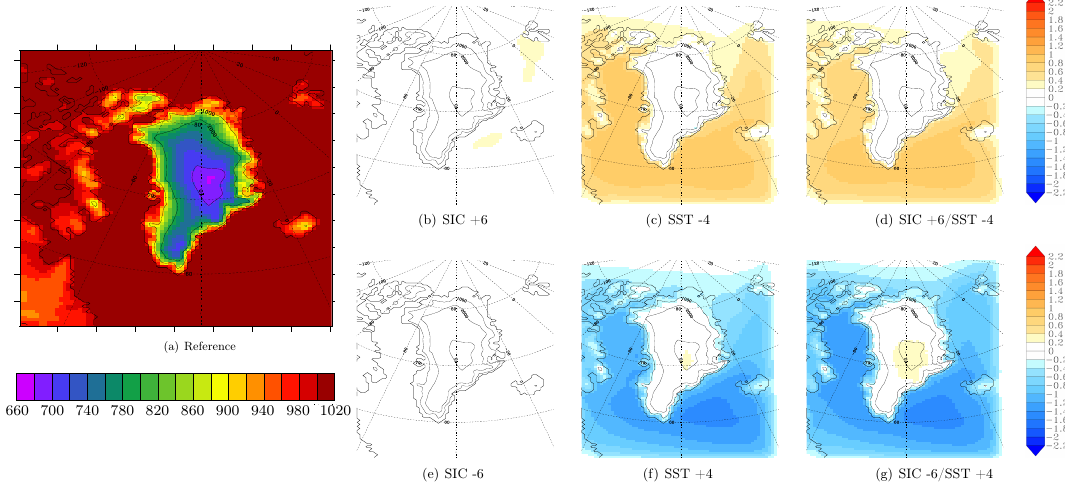
Figure 7. JJA mean surface pressure (hPa) for the reference run (a) over 2007–2012. Difference in JJA mean surface pressure (hPa) between (b) SIC + 6, (c) SST − 4, (d) SIC + 6/SST − 4, (e) SIC − 6, (f) SST + 4, (g) SIC − 6/SST + 4 experiments and the reference run.